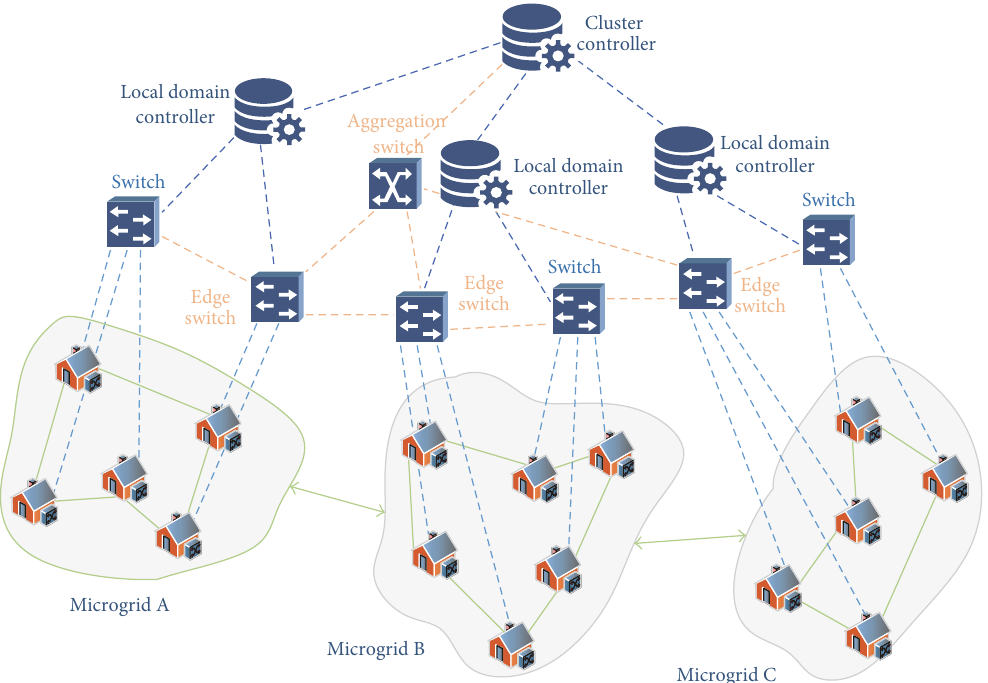
Figure 3: SDN-enabled microgrid cluster level communication network framework.